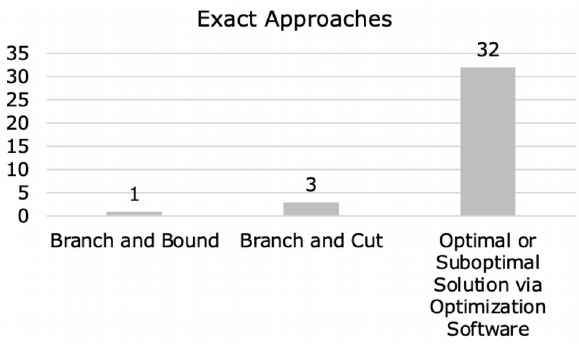
Figure 13. Statistics on the use of Exact